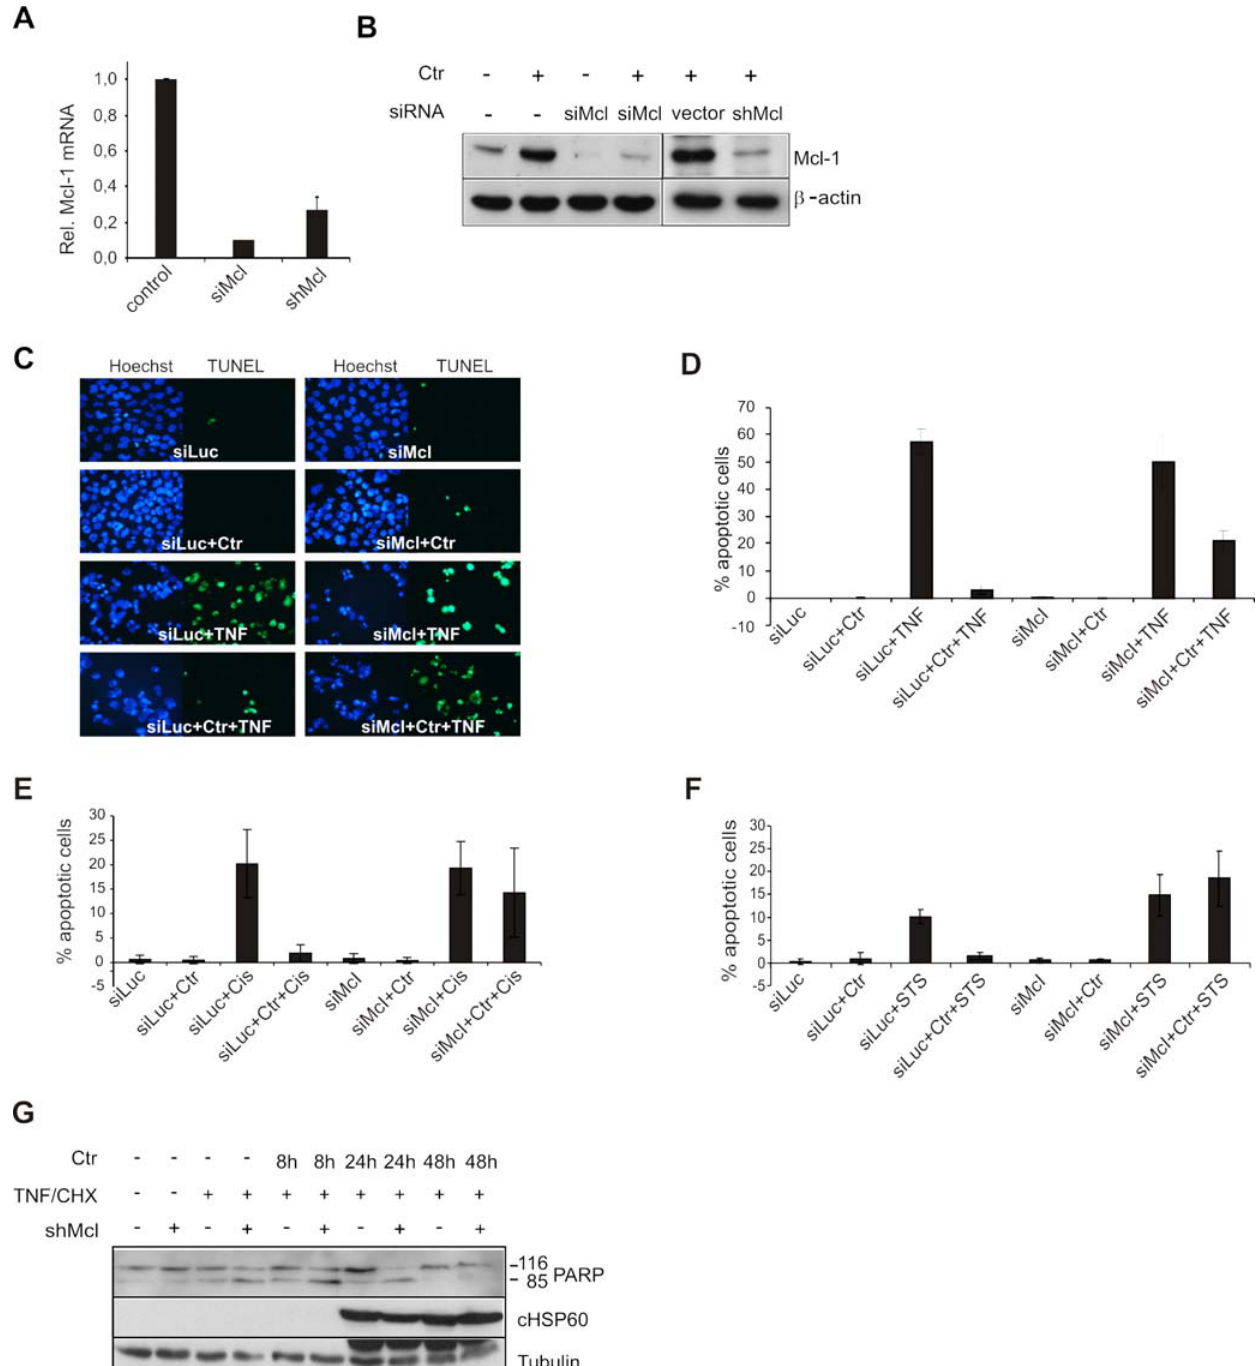
Figure 2. Mcl-1 is required to resist apoptosis induced by various inducers. (A,B) Si- or shRNAs directed against luciferase (siLuc)/empty vector (vector) and Mcl-1 (si/shMcl) were transfected into HeLa cells. The efficiency of silencing Mcl-1 was monitored by q-PCR (A) and by immunoblot analysis (B). (C–F) Cells were then infected (Ctr) at an MOI of 3 and induced to apoptosis by the treatment with TNF/CHX (TNF; C,D), cisplatin (cis; E) or staurosporine (STS; F) as indicated. Cells were fixed, the nuclei were stained with Hoechst (blue) and apoptotic cells were identified by the TUNEL assay (green). For quantification, TUNEL positive cells from each sample were counted from five different fields. Shown are the data from three independent experiments. The bars and the error bars represent the mean 6 SD, respectively. (G) Sensitization to TNF/CHX mediated cell death by silencing Mcl-1 in infected cells, is confined to the early stages of infection. Control and shMcl-expressing cells were infected as mentioned above and induced to apoptosis with TNF/CHX at various time points of infection. The cells were lysed in sample buffer and the processing of PARP was monitored by immunoblot analysis. Chlamydial Hsp60 (cHSP60) was detected to determine the infection load and Tubulin was used as a loading control.